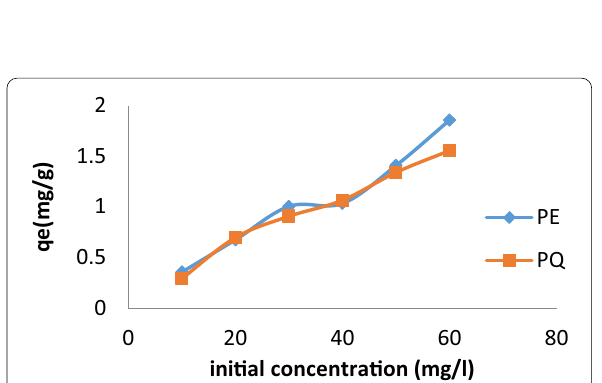
Fig. 6 Effect of initial concentration on adsorption of ACBGNS onto PE and PQ (adsorption conditions: concentration of PE and PQ 10–50 mg/l, m = solution 10 cm 3 , agitation speed =